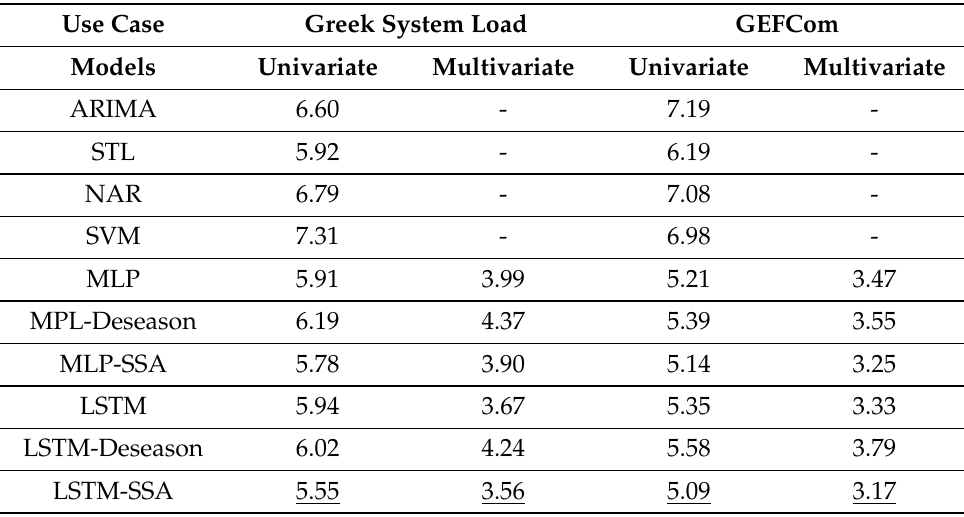
Table 1. MAPE results for the examined use